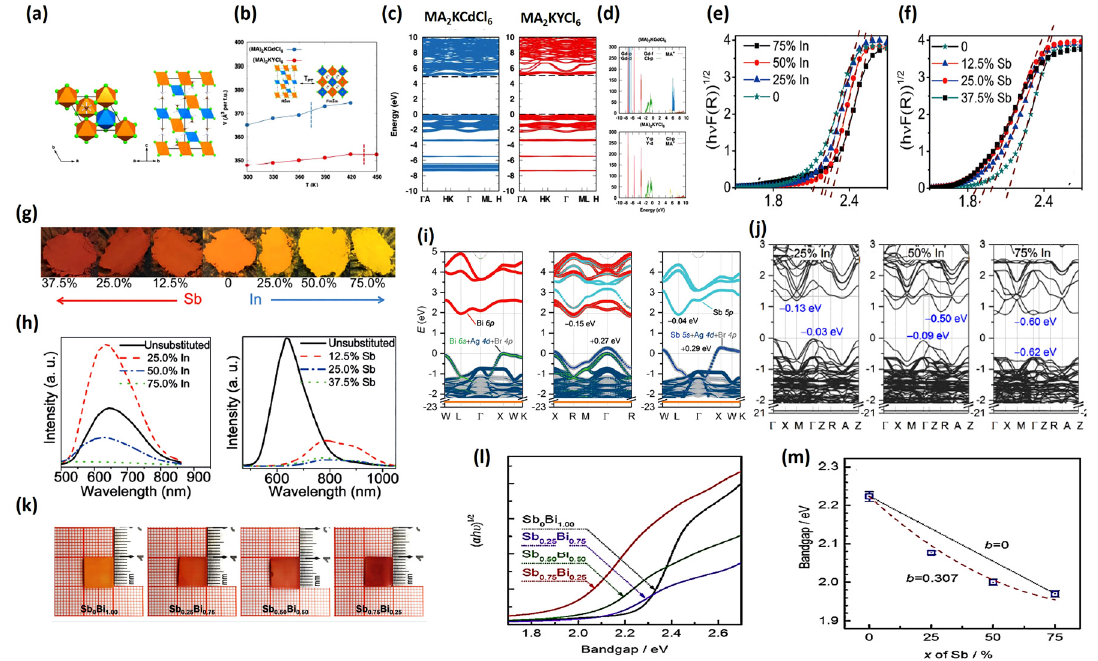
Figure6: Conventionalunitcellsof rhombohedral MA 2 KBCl 6 (B=GdandY) atroomtemperatureviewed(a)alongthe c -axisand(b)parallelto the a – b plane [122]. Copyright 2017 American Chemical Society. (c) Volumes per formula unit (f.u.) of MA 2 KGdCl 6 and MA 2 KYCl 6 upon